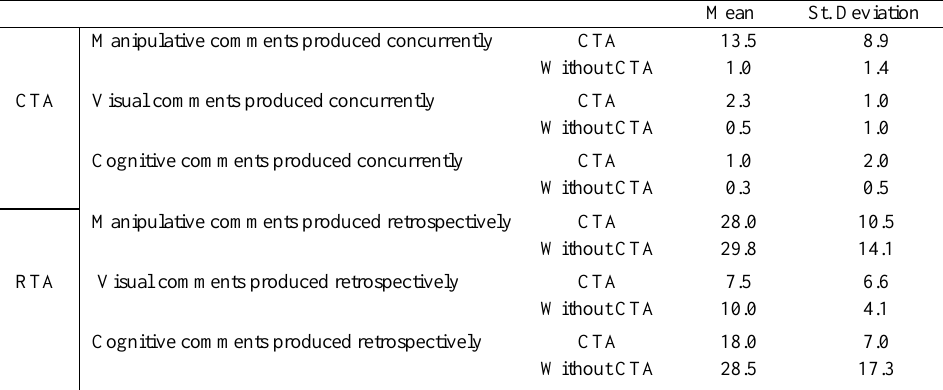
Table III Means and standard deviations for number of comments produced in different conditions and stages